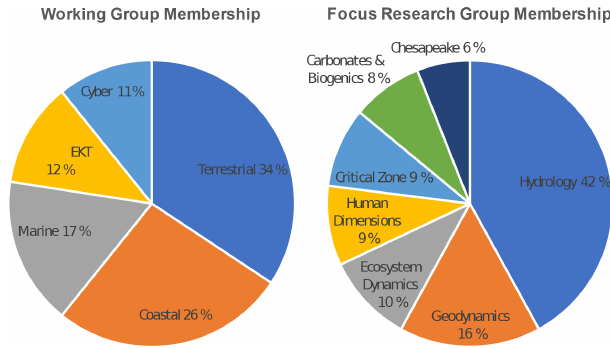
Figure 15. CSDMS Working Groups and Focus Research Groups (EKT stands for Education and Knowledge